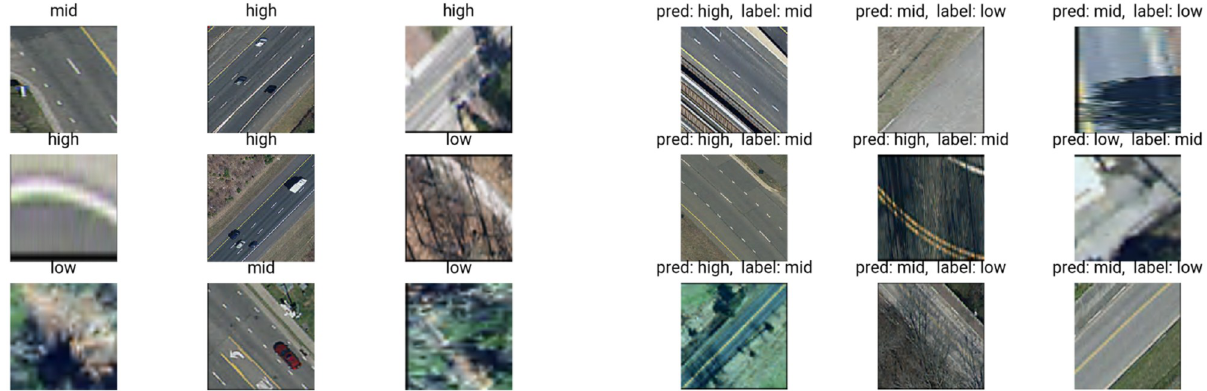
Fig 5. Predictions. On the left, a 3x3 group of correct predictions with associated labels and, on the right, a 3x3 group of incorrect predictions with predictions and labels.